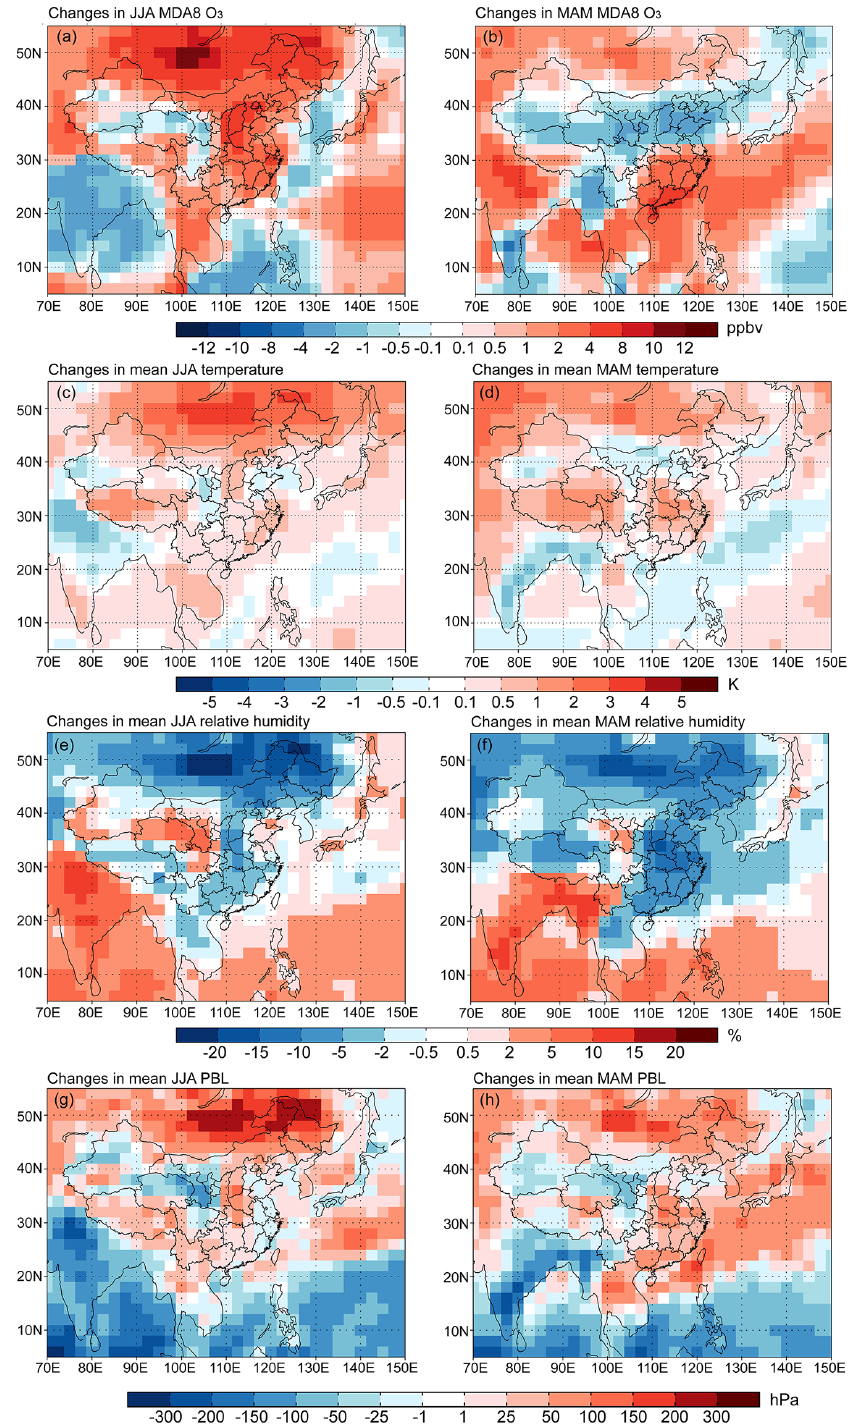
Figure 4. Changes in (a) surface maximum daily 8-h average ozone concentration (MDA8 O 3 ) in summer (JJA); (b) surface MDA8 O 3 in spring (MAM); (c) mean JJA temperature; (d) mean MAM temperature; (e) mean JJA relative humidity; (f) mean MAM rela- tive humidity; (g) mean JJA planetary boundary layer (PBL); and (h) mean MAM PBL driven by 1980–2010 changes in climate alone ([CTRL] − [SIM_CLIM]). Values are differences between the 5-year averages over the present-day and historical periods.